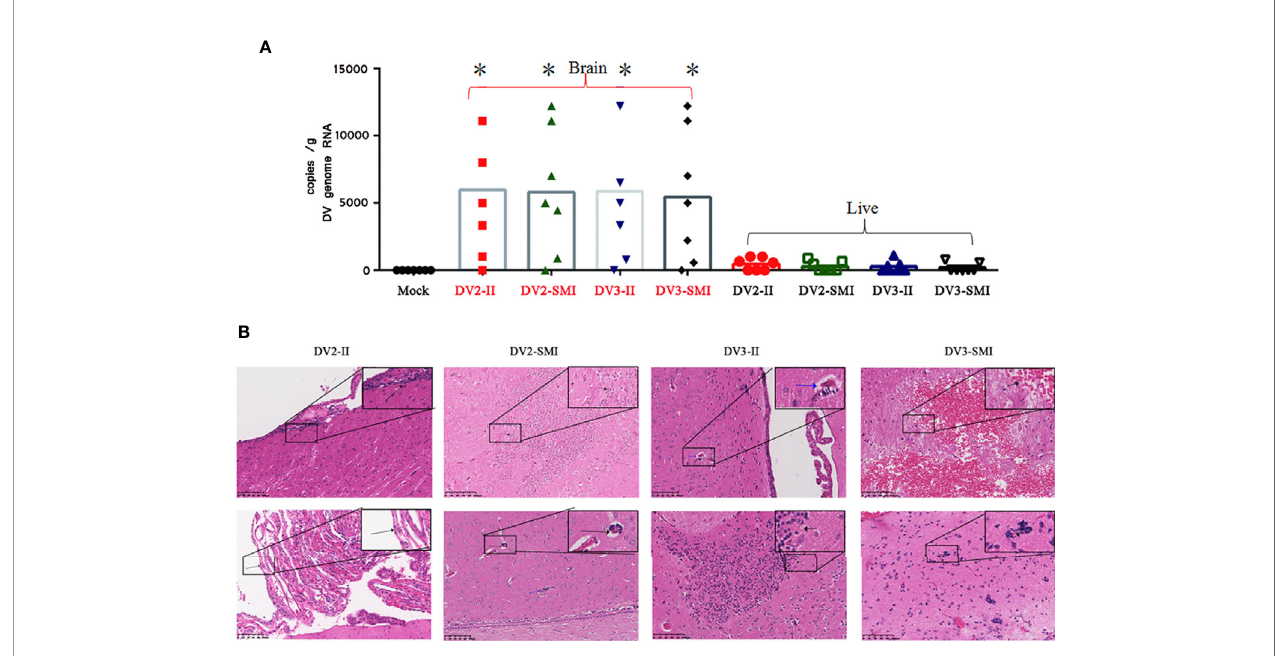
FIGURE 4 | Viral RNA copies and H&E analysis in tissues of DENV-2 and DENV-3 infected tree shrew. (A) Genome RNA of DENV in the liver and brain. Circle dots represent the control group. 48 days post infection. High viral RNA copies were detected in the brain. The results from each group were compared using Student ’ s t test. *P <0.05. (B) Histopathology aspects of Tupaia chinensis brain tissue 48 days post infection of DENV-2 (DV2) and DENV-3 (DV3). DV2-II, a small number of in fl ammatory cells were seen locally near the ventricle in brain tissue (Black arrow) and local proliferation of arachnoid endothelial cells in brain tissue (Black arrow) were observed. The Blood vessel sleeve (Black arrow) and glial nodule (Blue arrow) were observed in brain tissue of DV2-SMI. DV3-II, glial nodules (Black arrow), individual vascular sleeves (Blue arrow) and proliferation of keratinocytes (Black arrow) in brain tissue were observed. DV3-SMI, hemorrhagic foci of brain tissue (Black arrow) and multiple glial nodules in brain tissue (Black arrow) were observed. *P